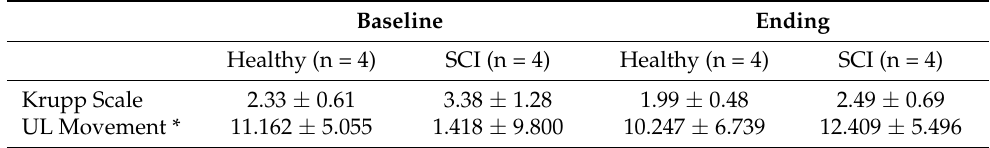
Table 3. Results in the Krupp scale and the UL movements number at baseline (before starting the training) and at the end of all the experimental sessions.